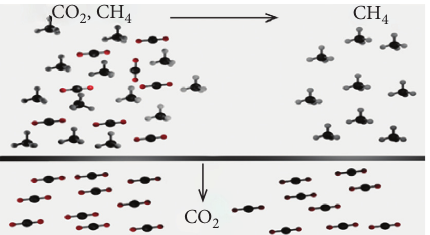
Figure 4: Polymer matrix forming nanocomposite membranes with enhanced gas